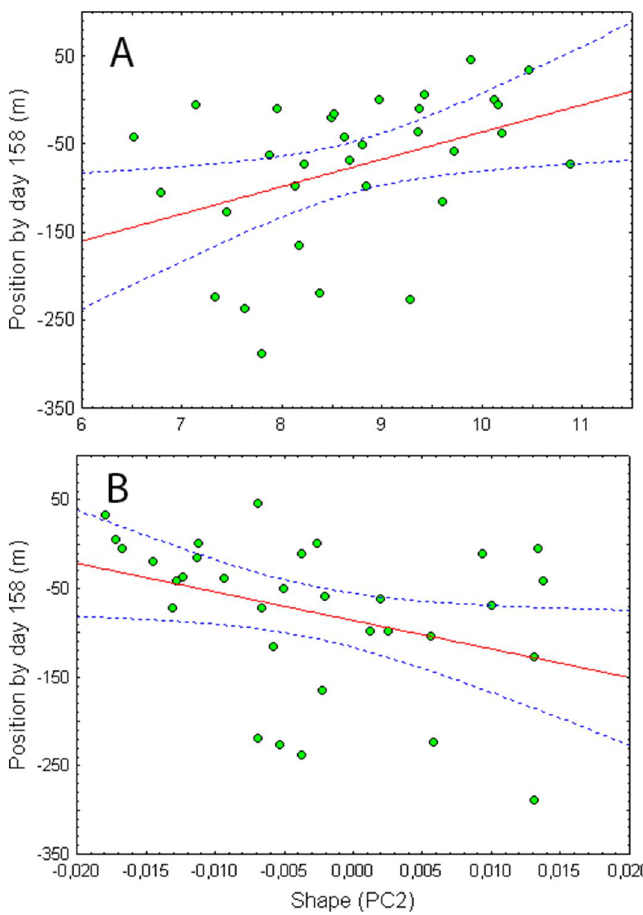
Figure 4. Regression of settlement positions by day 158 (distances from the release point at the end of the experiment) on ( A ) initial size (centroid size before release; F 1,30 = 5.71, P = 0.028) and ( B ) shape before release (PC2; F 1,30 = 4.56, P = 0.041). Negative and positive values for ‘position’ refer to locations downstream and upstream of the release point, respectively.